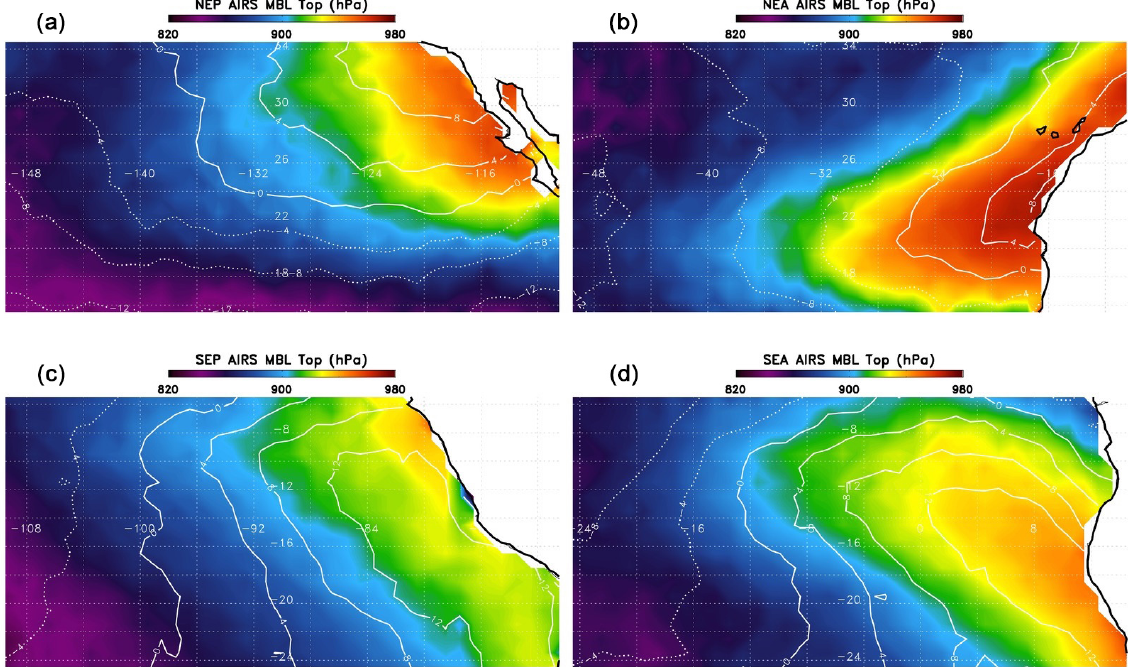
Figure 4. MBL depth (hPa) for regions listed in Table 1: (a) NEP, (a) NEA, (c) , SEP, and (d) SEA. The AIRS 1000–700hPa dMSE is overlaid in white contours (solid are for positive, and dashed for